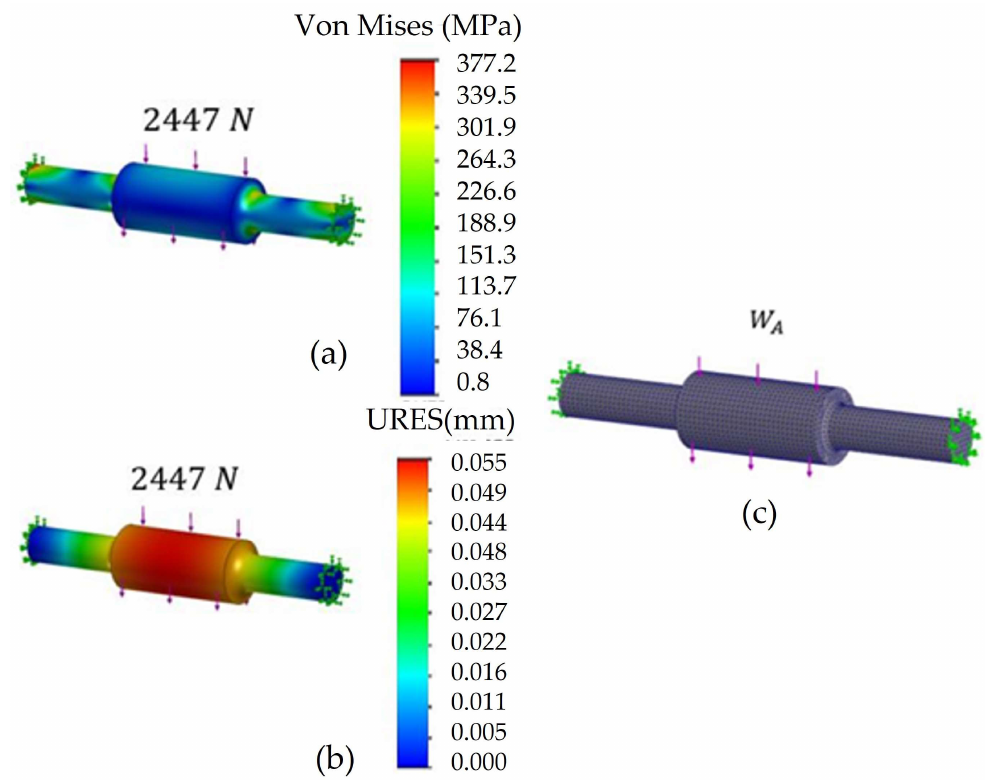
Figure 9. FEM analysis for the upper axle of the shock absorber: ( a ) von Mises stress; ( b ) displacement; ( c ) mesh details.